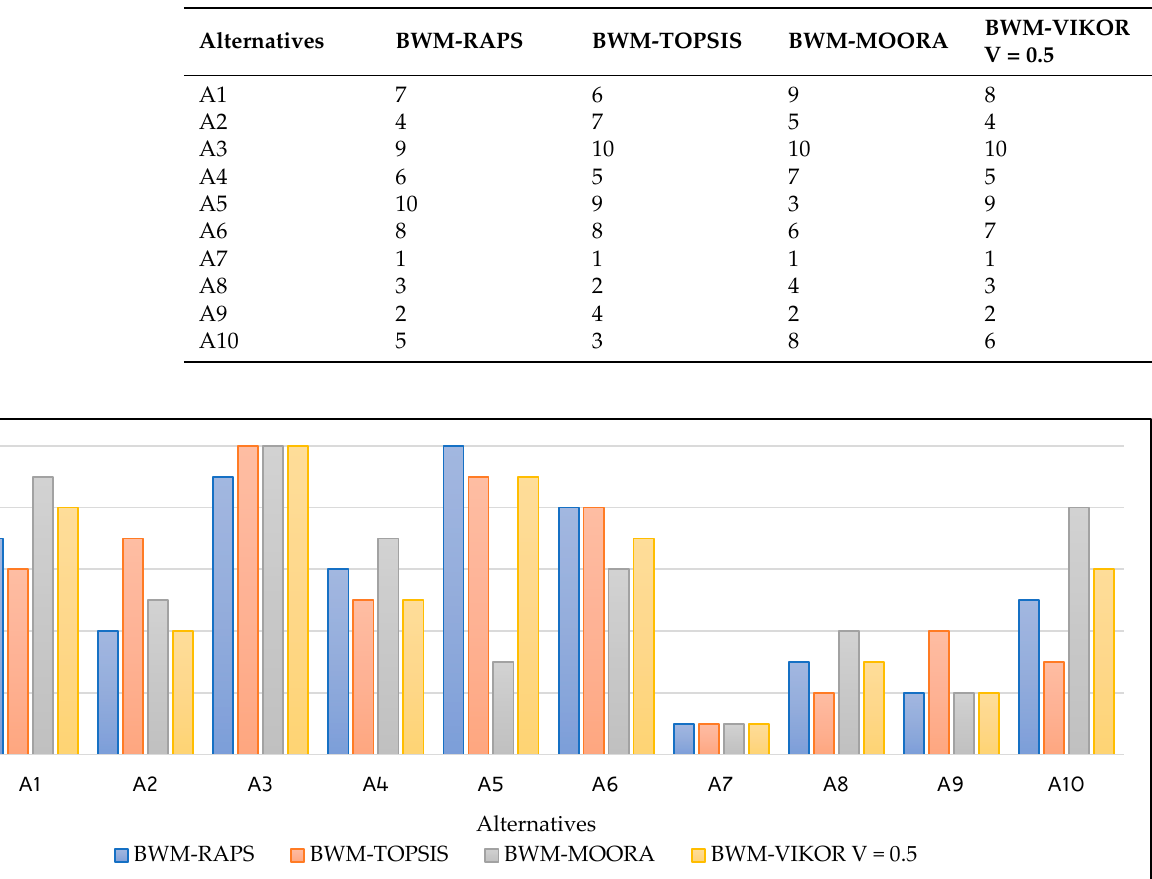
Table 9. A comparative MCDM analysis.